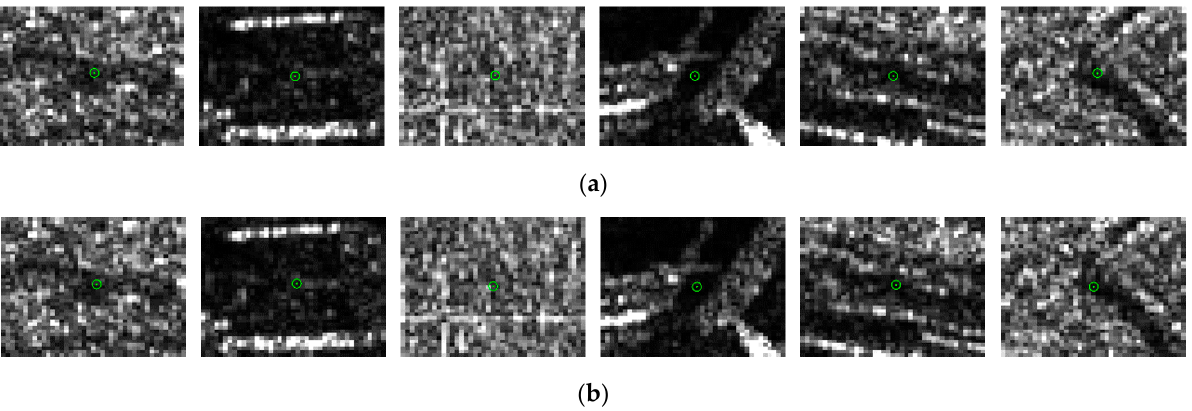
Figure 9. Comparison of six pairs of randomly selected tie-points in the strip and their SAR images, where ( a ) is the master image and ( b ) is the slave image.